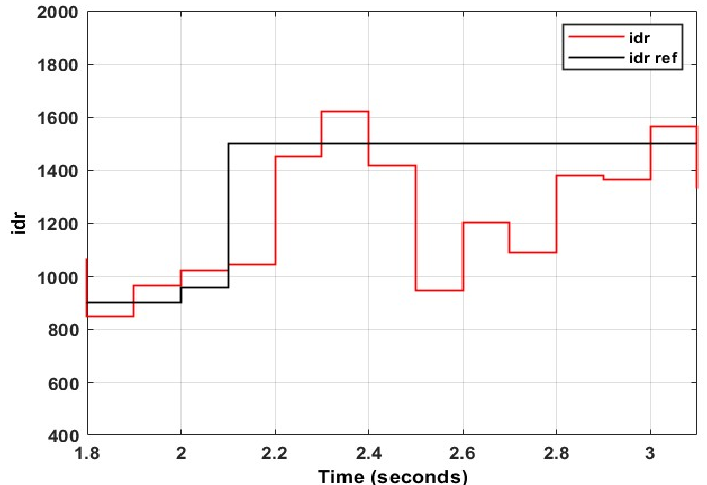
Figure 48. Rotor direct axis current average using PI at 90% dip.